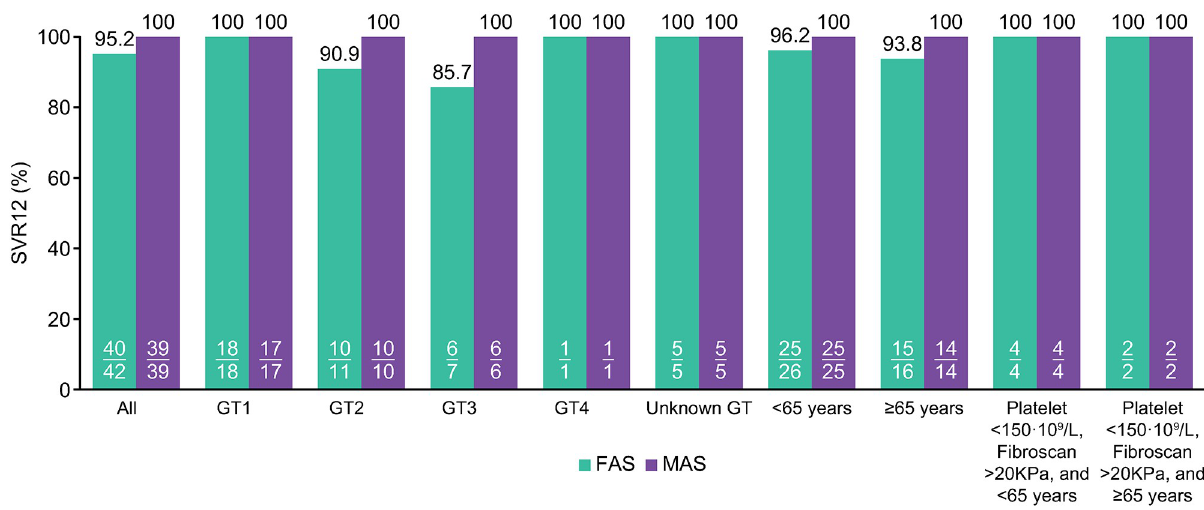
Fig 2. SVR12 by genotype and subgroups of interest. FAS full analysis set; GT genotype; MAS modified analysis set; SVR12 sustained virological response 12 weeks post-treatment.